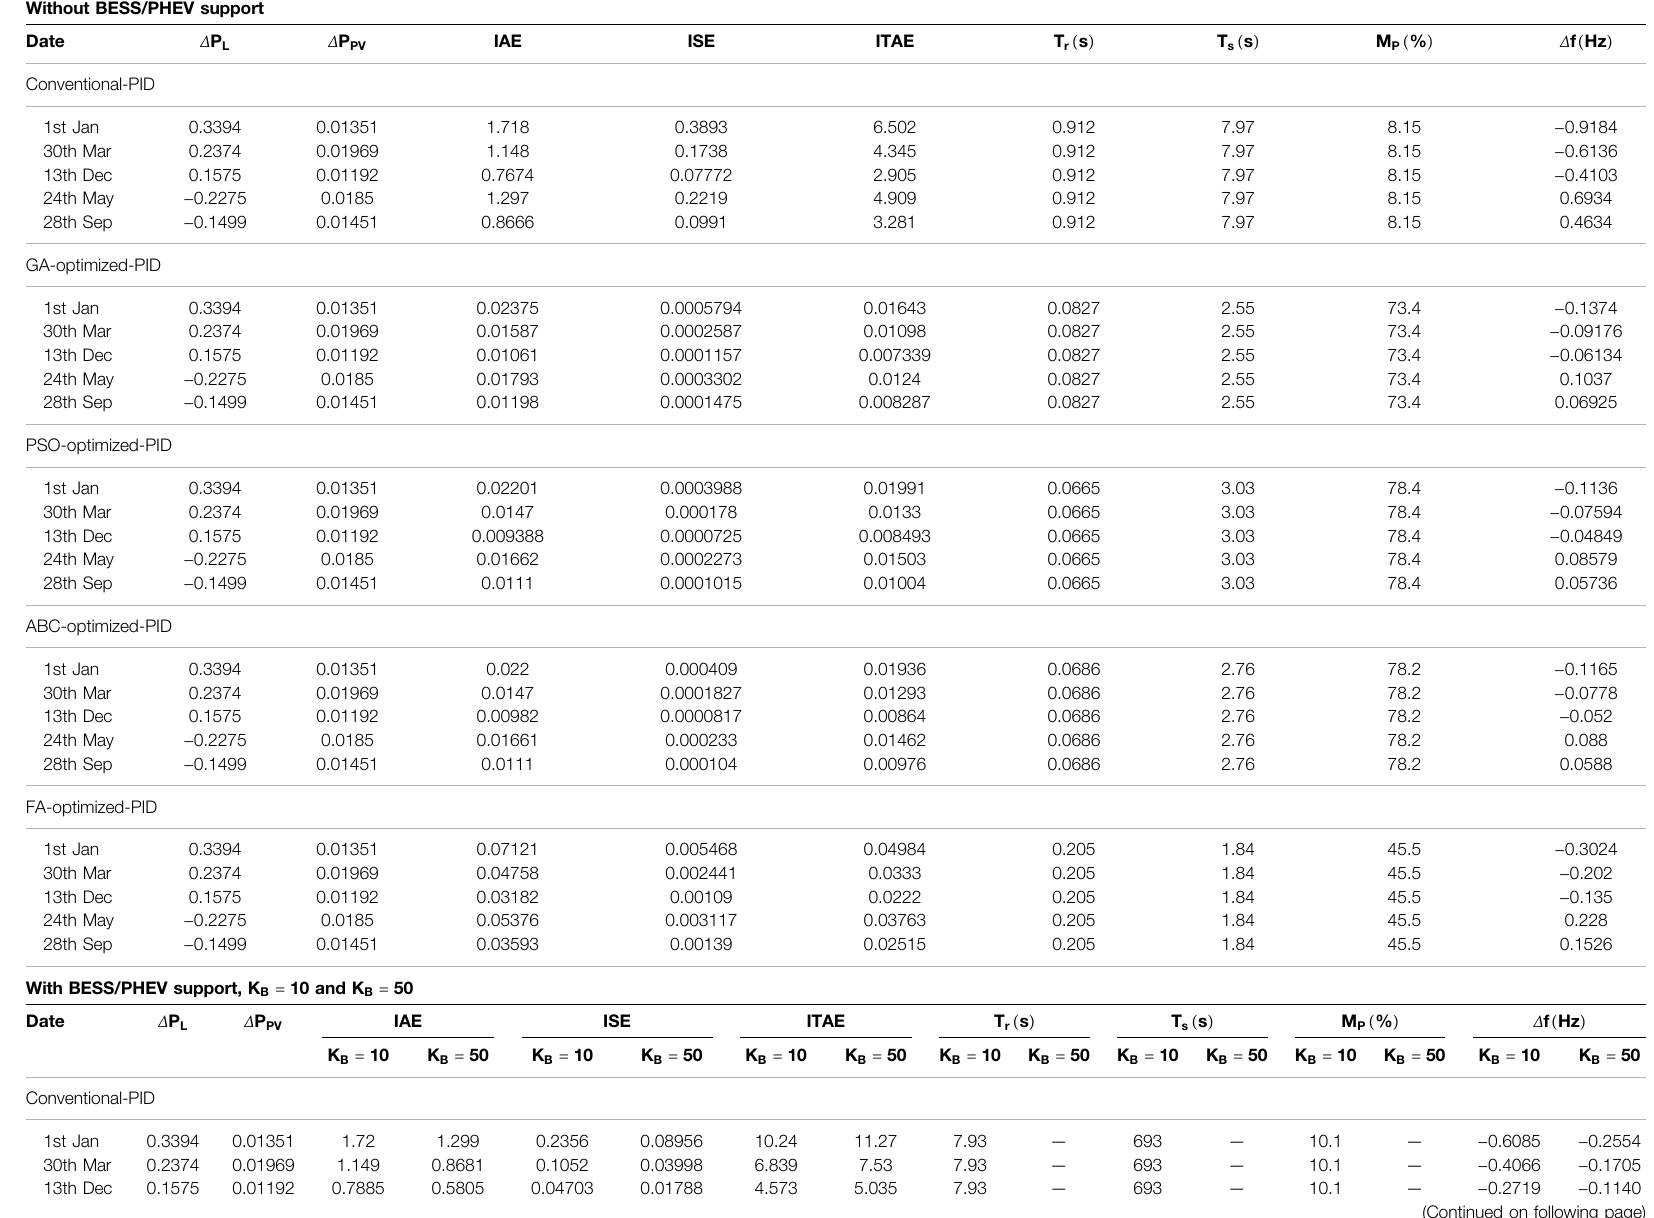
TABLE 8 | Frequency deviation parameter indices using integral time absolute error objective